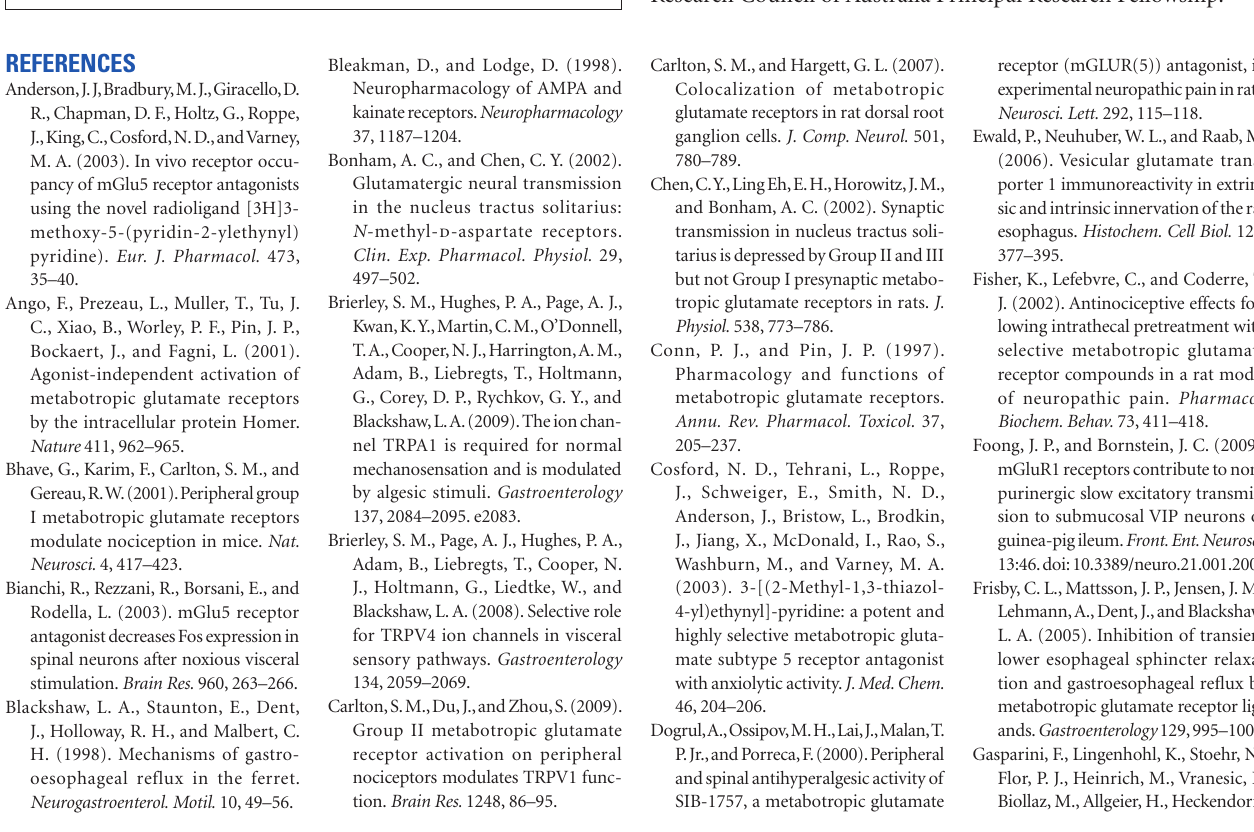
Figure 3 | Mechanism of mglur action on transient lower esophageal sphincter relaxations (TLeSr). Vagal tension receptors in the proximal stomach detect stretch of the wall by gastric content. They project into the brainstem where they synapse mainly on interneurons. A central program generator is triggered which probably comprises several inhibitory and excitatory neurons interacting pre- and post-synaptically. The output from the program generator is an episodic, powerful activation of vagal efferents projecting to the myenteric plexus of the LES. At this point they activate inhibitory intrinsic motorneurons which release inhibitory transmitter onto smooth muscle. mGluR may be found at several points throughout this circuit, both peripherally and centrally. Their role appears to be mainly presynaptic, and in some cases mainly peripheral (see text). Their role within the program generator and along vagal motor pathways is not